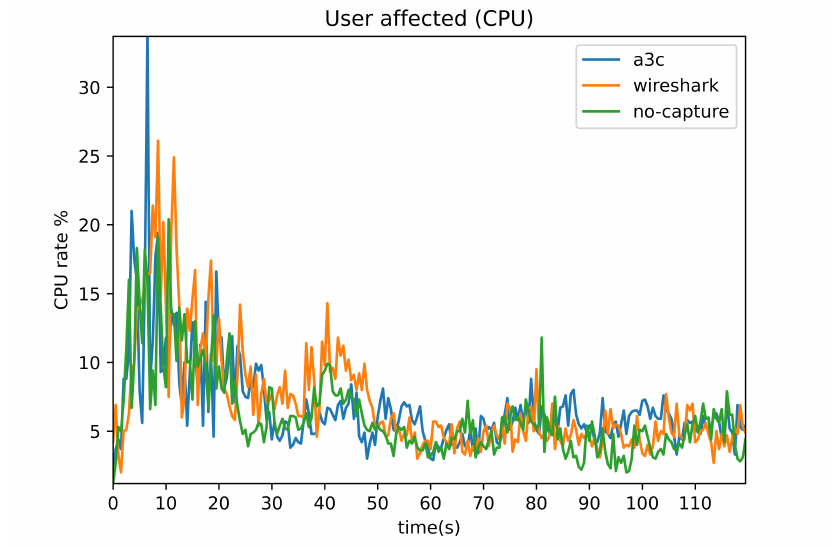
Figure 10. System resource occupation comparison of A3C-Linux to